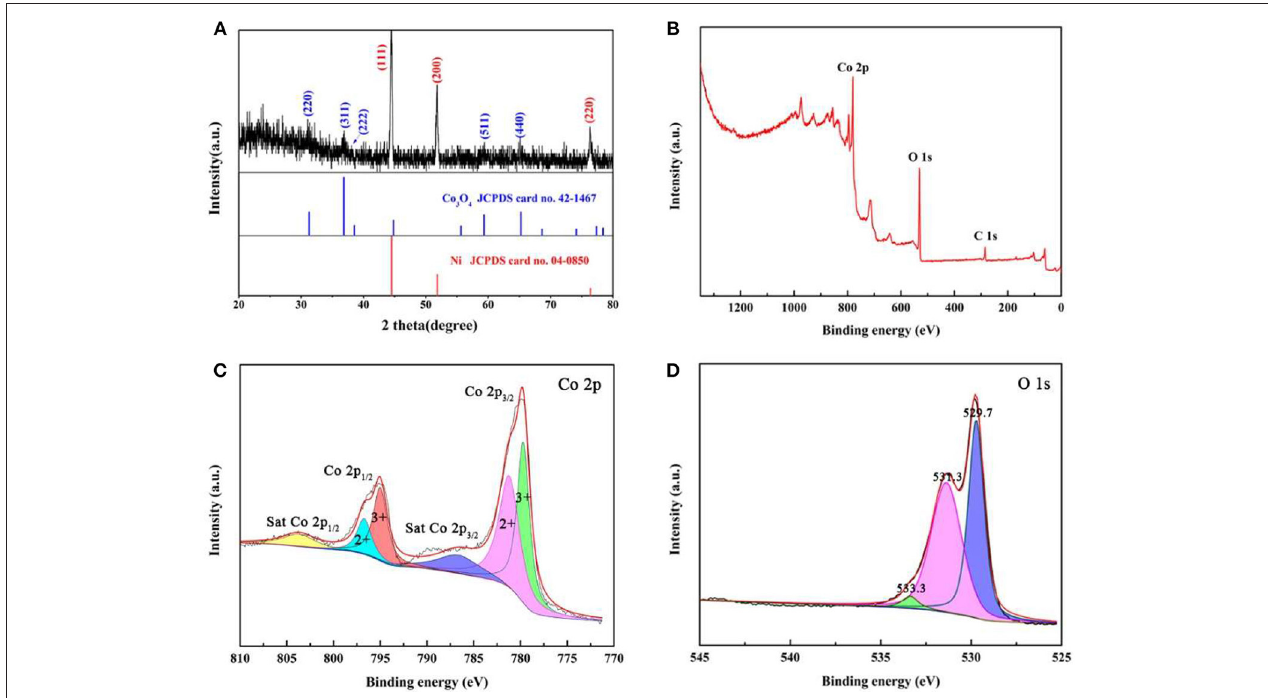
FIGURE 3 | (A) XRD patterns of Co 3 O 4 NWAs on Ni foam, (B) XPS spectra of Co 3 O 4 NWAs, (C) XPS survey scan of Co 2p, and (D) XPS survey scan of O 1s.